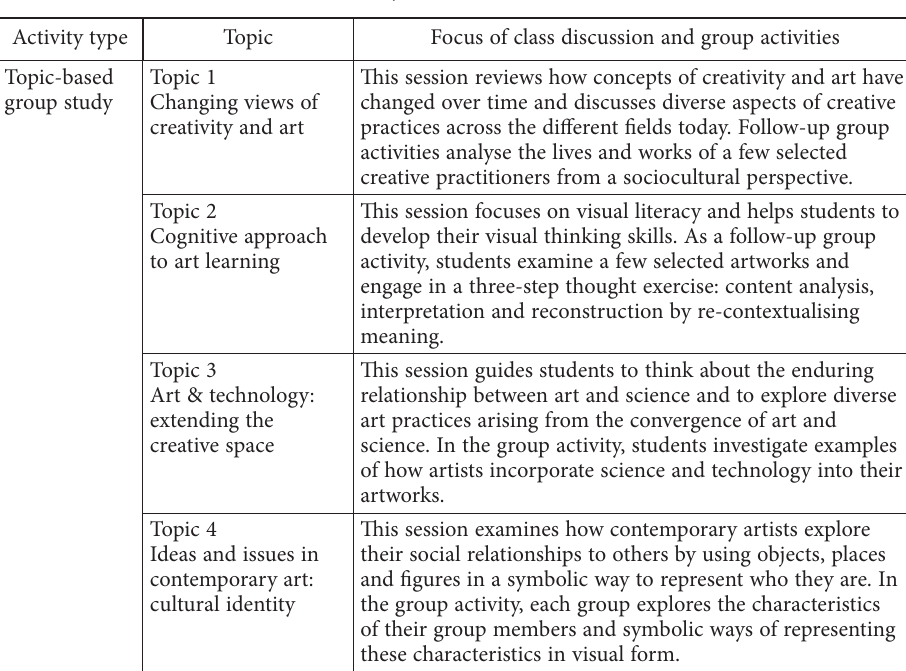
Table 1. Course structure (source: created by